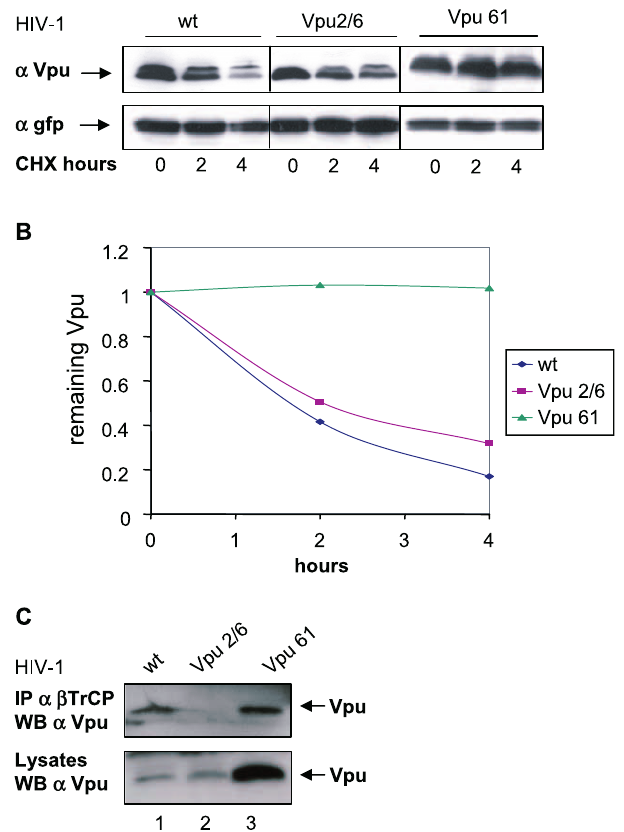
Figure 4. Mutation of Vpu S61 in the HIV-1 Virus Markedly Extends the Viral Protein Half-Life While Preserving Its Interaction with b TrCP (A) HeLa cells were transfected with 0.5 l g of HIV-1 proviral DNA corresponding to pNL4–3 wild-type, pNL4–3 Vpu 2/6, or pNL4–3 Vpu S61Q together with 0.05 l g of GFP expression vector used as a control for the transfection. Cells were treated with cycloheximide and harvested at the indicated time points. Cell lysates were separated by SDS-PAGE and analyzed by western blot for GFP and Vpu expression. (B) Quantification of Vpu expression shown in (A). After quantification, the signals obtained in (A) were used to calculate the Vpu/GFP expression ratios at the indicated time points after cycloheximide addition. (C) The S61 Vpu mutant conserves binding to b TrCP in cells transfected with HIV-1 proviral DNAs. HeLa cells were transfected with 0.5 l g of HIV-1 proviral DNAs encoding the indicated Vpu proteins. Cell lysates were immunoprecipitated with anti- b TrCP antibodies and analyzed for Vpu expression (top) or directly analyzed with Vpu antibodies